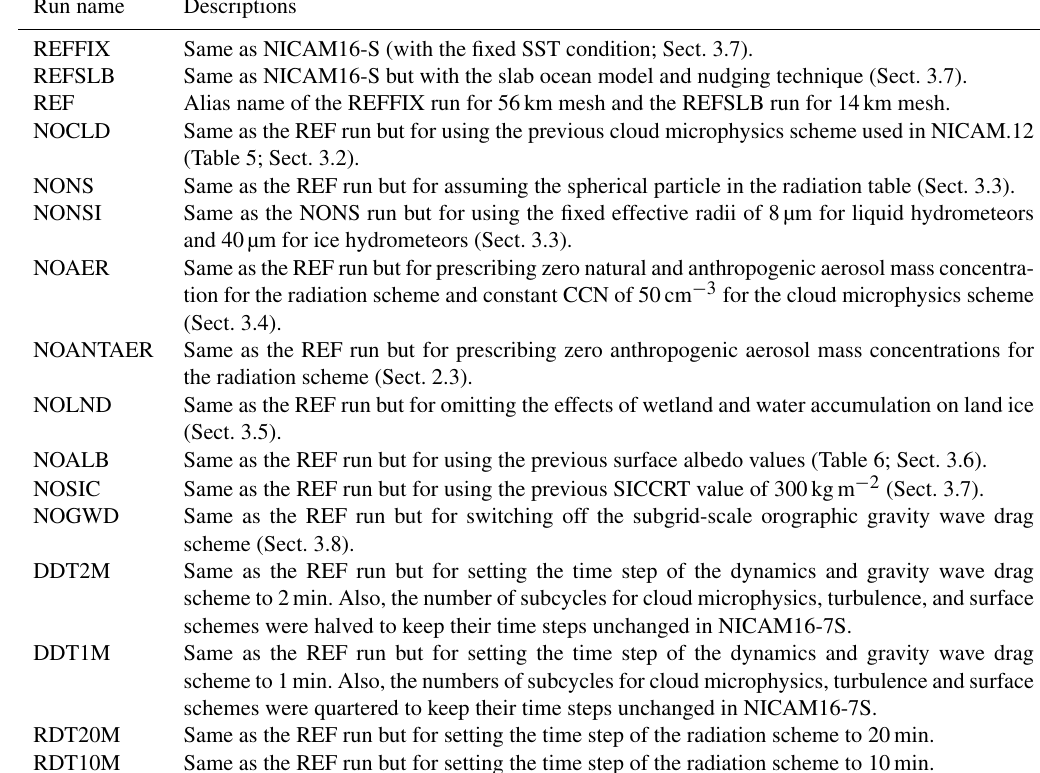
Table 2. List of sensitivity